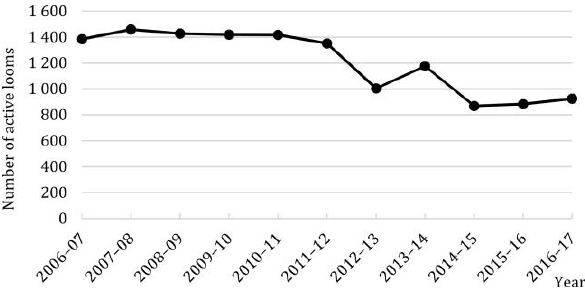
Fig. 5. Year wise number of active looms (Chinsurah zone) (Source: Handloom Development Office, Chinsurah, 2017)